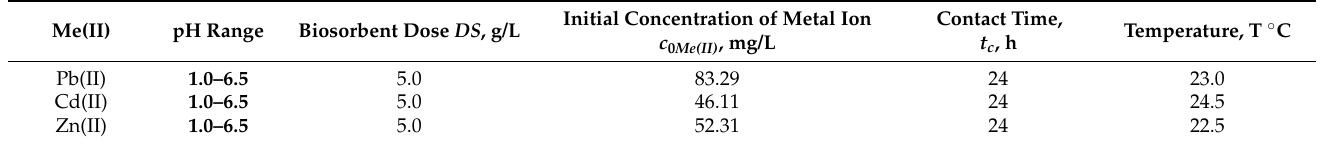
Table 2. Values of working parameters used in the experimental study on the influence of the initial pH of aqueous solution on the biosorption process.